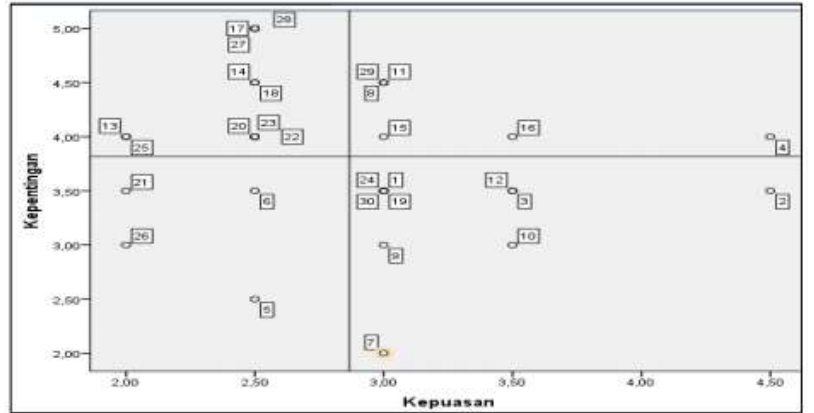
Figure 6. Result of Importance Performance Analysis (IPA) Pangkalpinang Source: Processed,